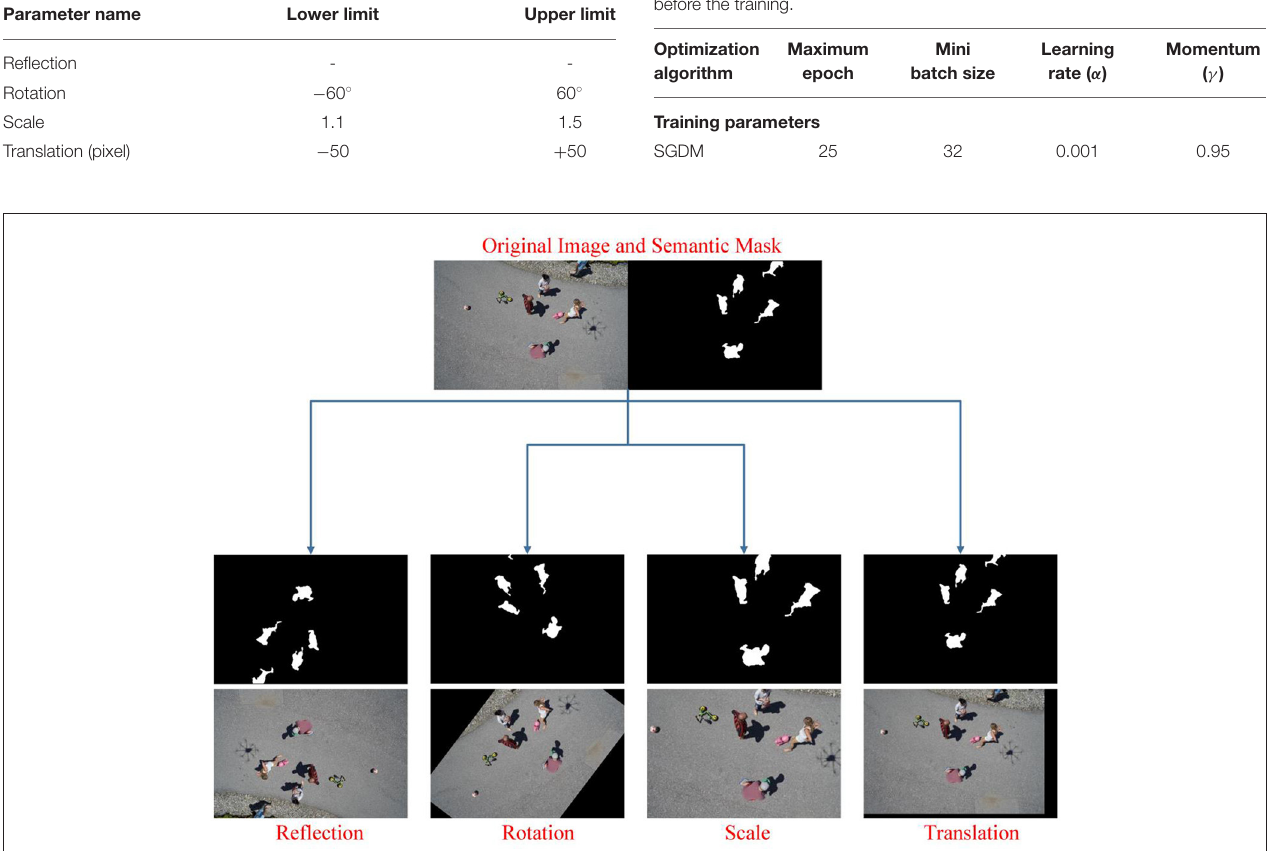
FIGURE 9 | Demonstration of the data augmentation methods used on a sample RGB and mask images (The number of both RGB and mask images is increased for more robust training of the Segnet network).